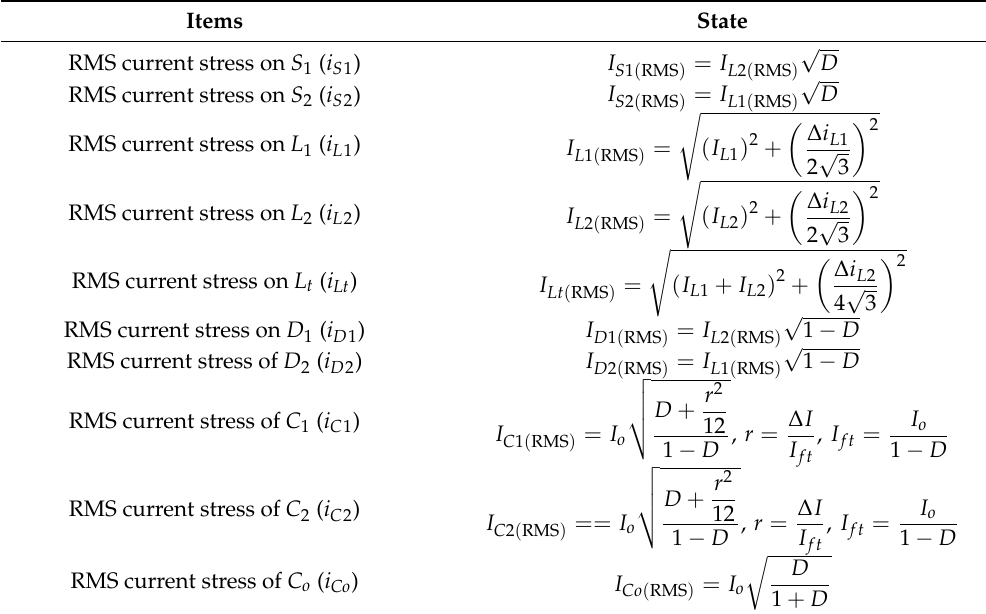
Table 1. The results for stress analysis in steady-state.